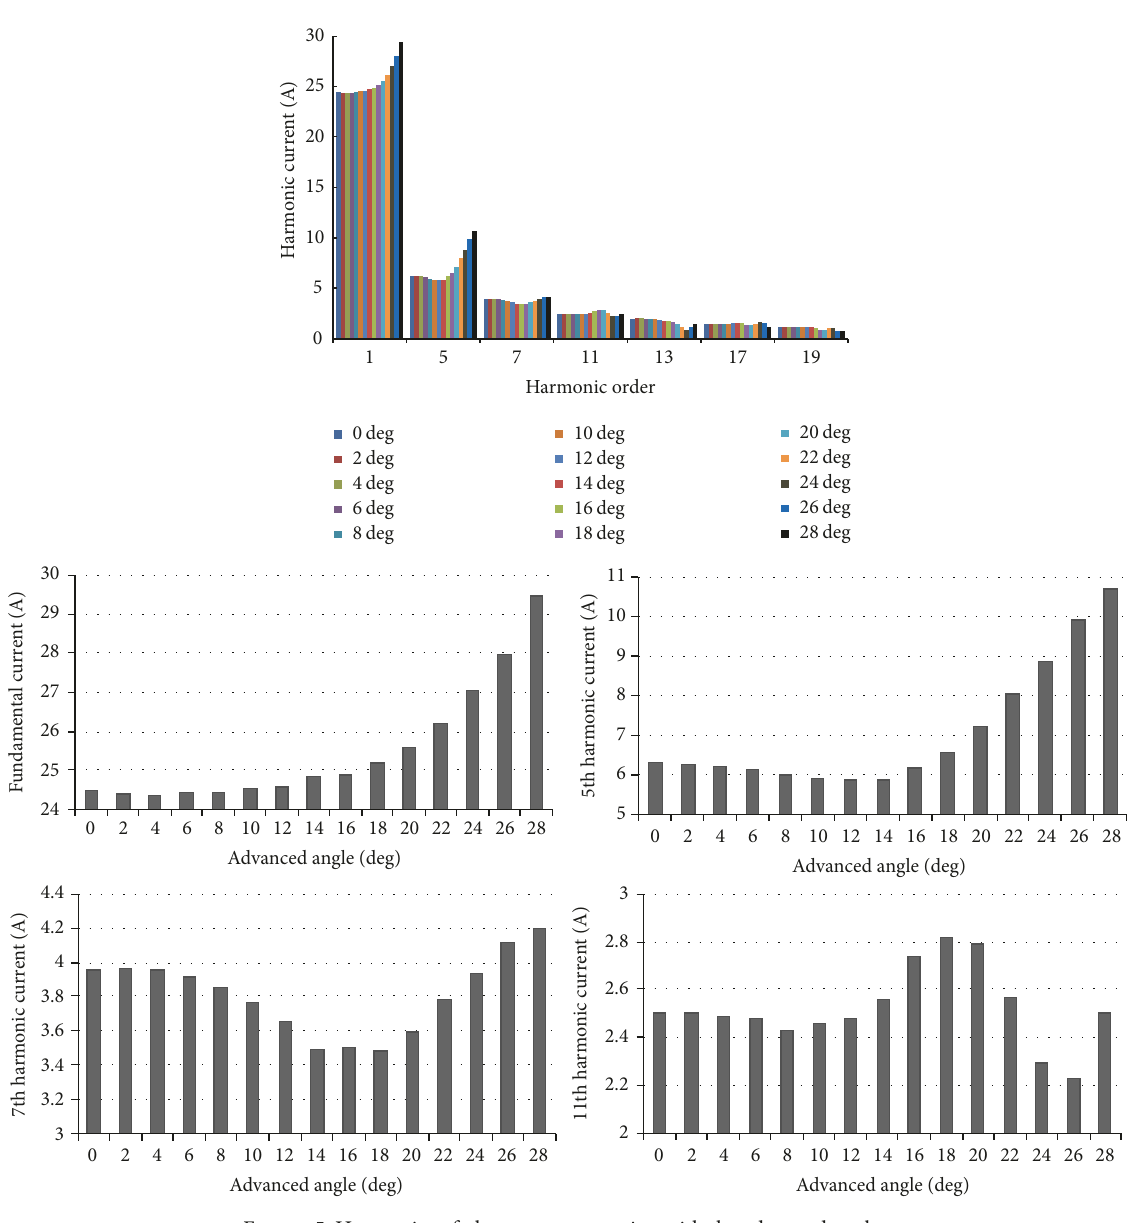
Figure 5: Harmonics of phase current varying with the advanced